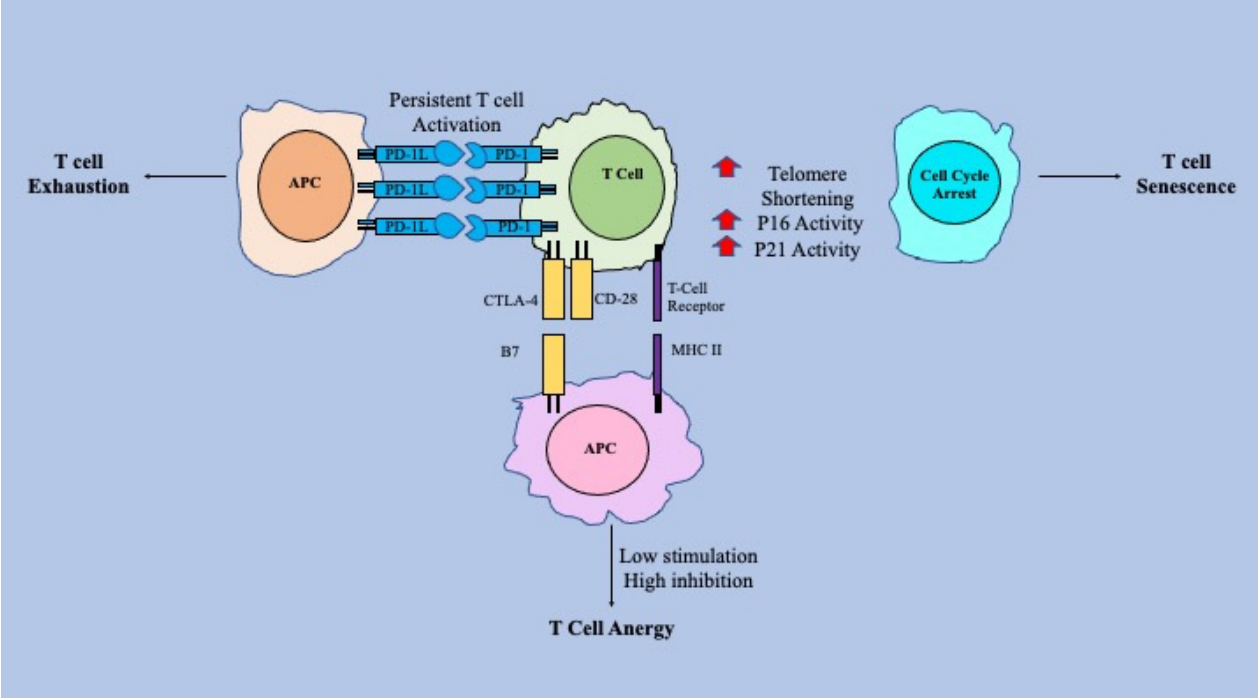
Figure 1. Ageing-associated mechanisms of T-cell dysfunction.